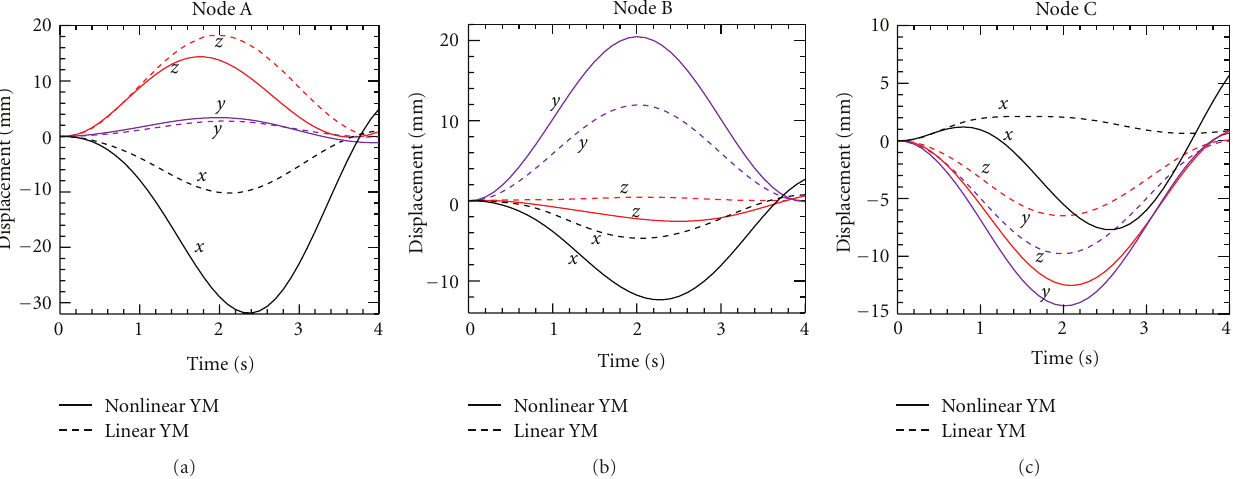
Figure 9: Predicted displacements for monitored nodes A, B, and C for linear and anisotropic YM over the first respiration